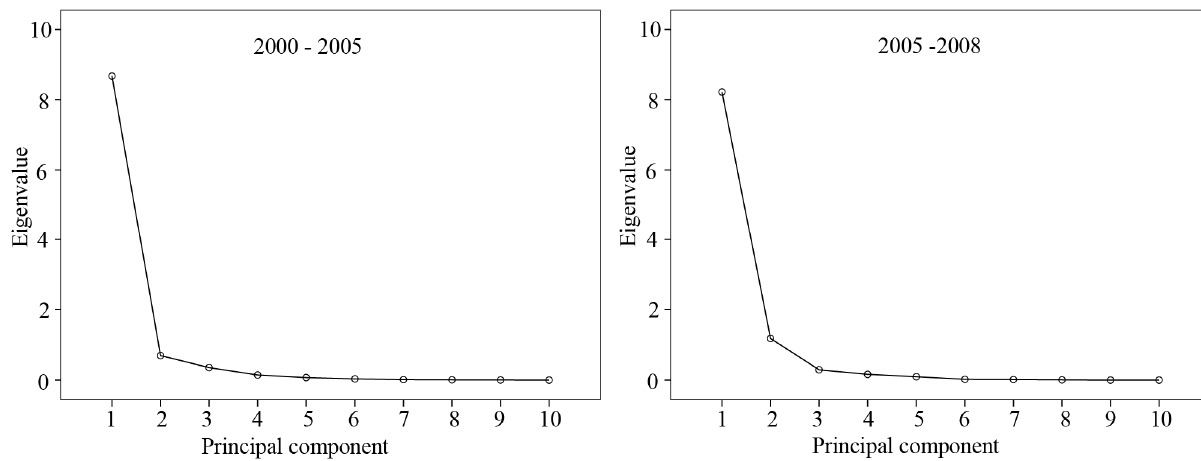
Figure 6. Scree plot of eigenvalues.